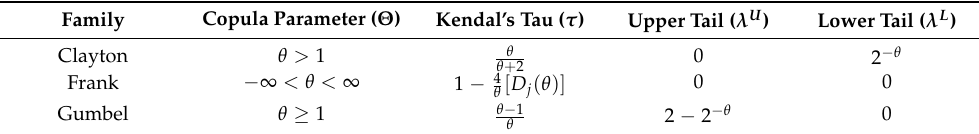
Table 2. The relationship between the bivariate Archimedean copula parameter ( θ ) and tail depen- dence coefficients: Kendall’s tau ( τ ) and tail dependence ( λ U and λ L